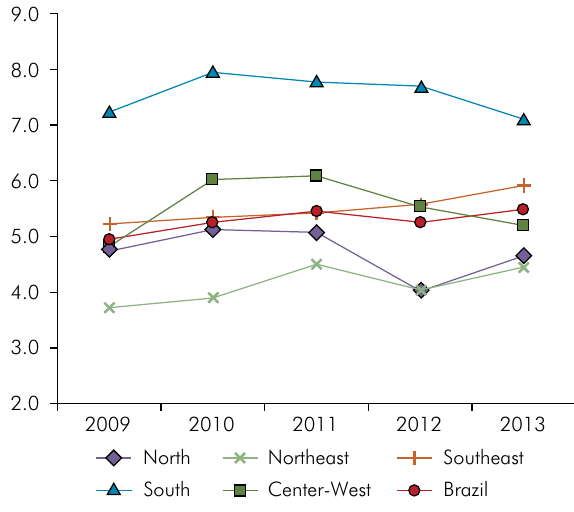
Figure 2. Orofacial cleft prevalence per 10,000 live births according region and years, in Brazil from 2009 to